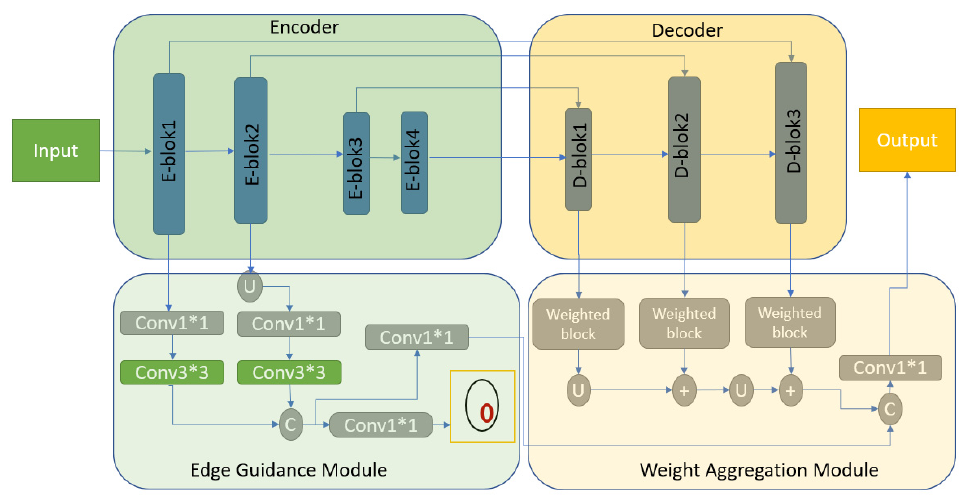
Figure 6. ET-Net architecture.